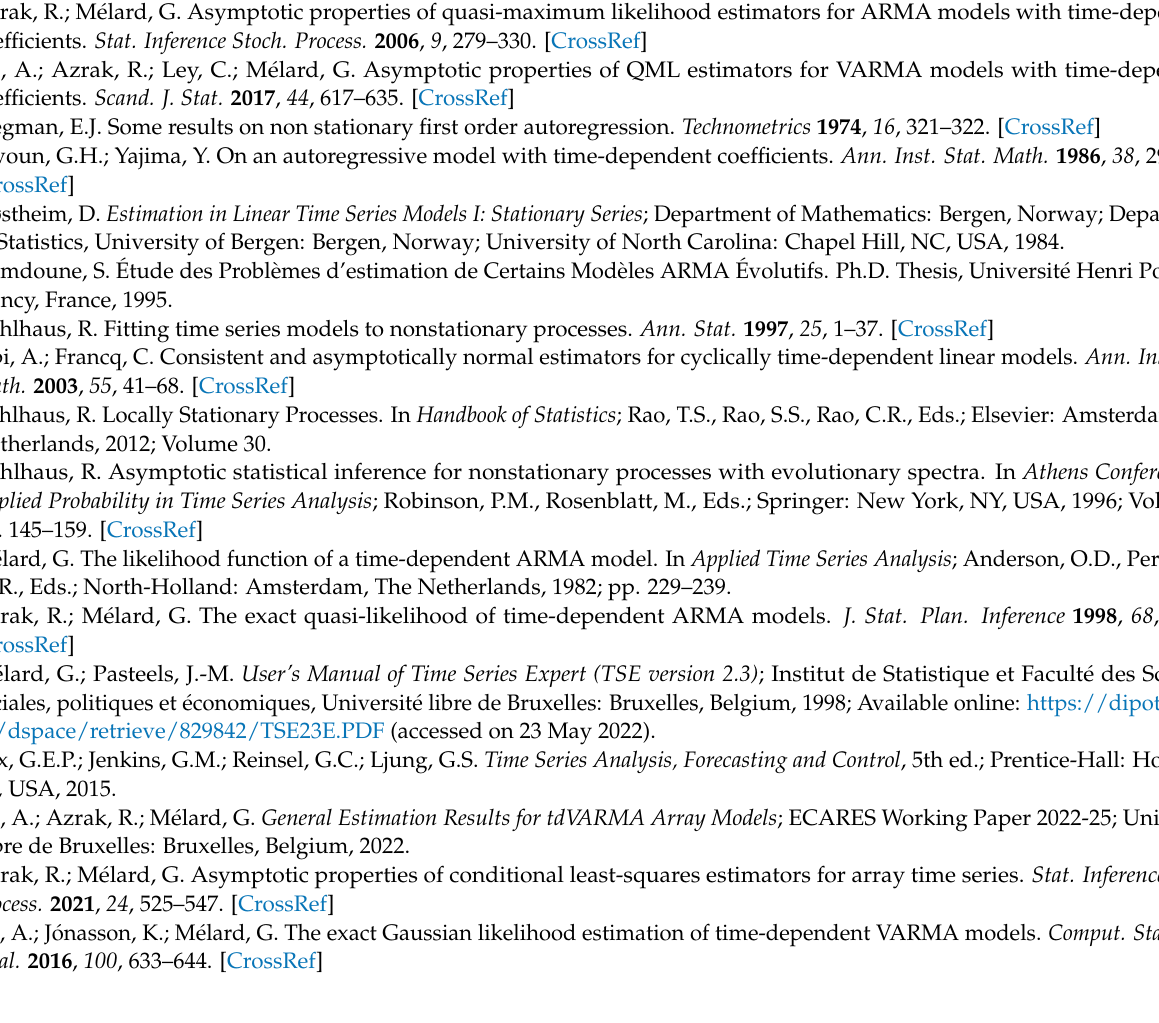
, φ (cid:48)(cid:48) , φ (cid:48) and 2 1 1